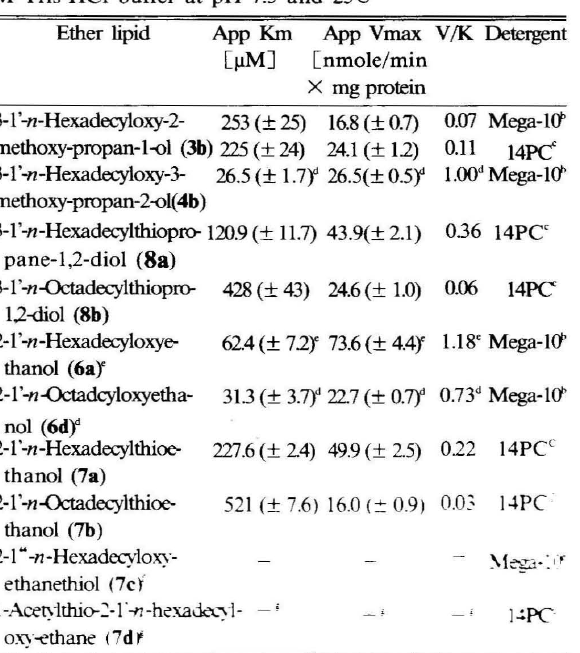
Table 2. Kinetic parameters of glycetyl-ether monooxygenase with miscelaneous ether and thioether lipid substrates in